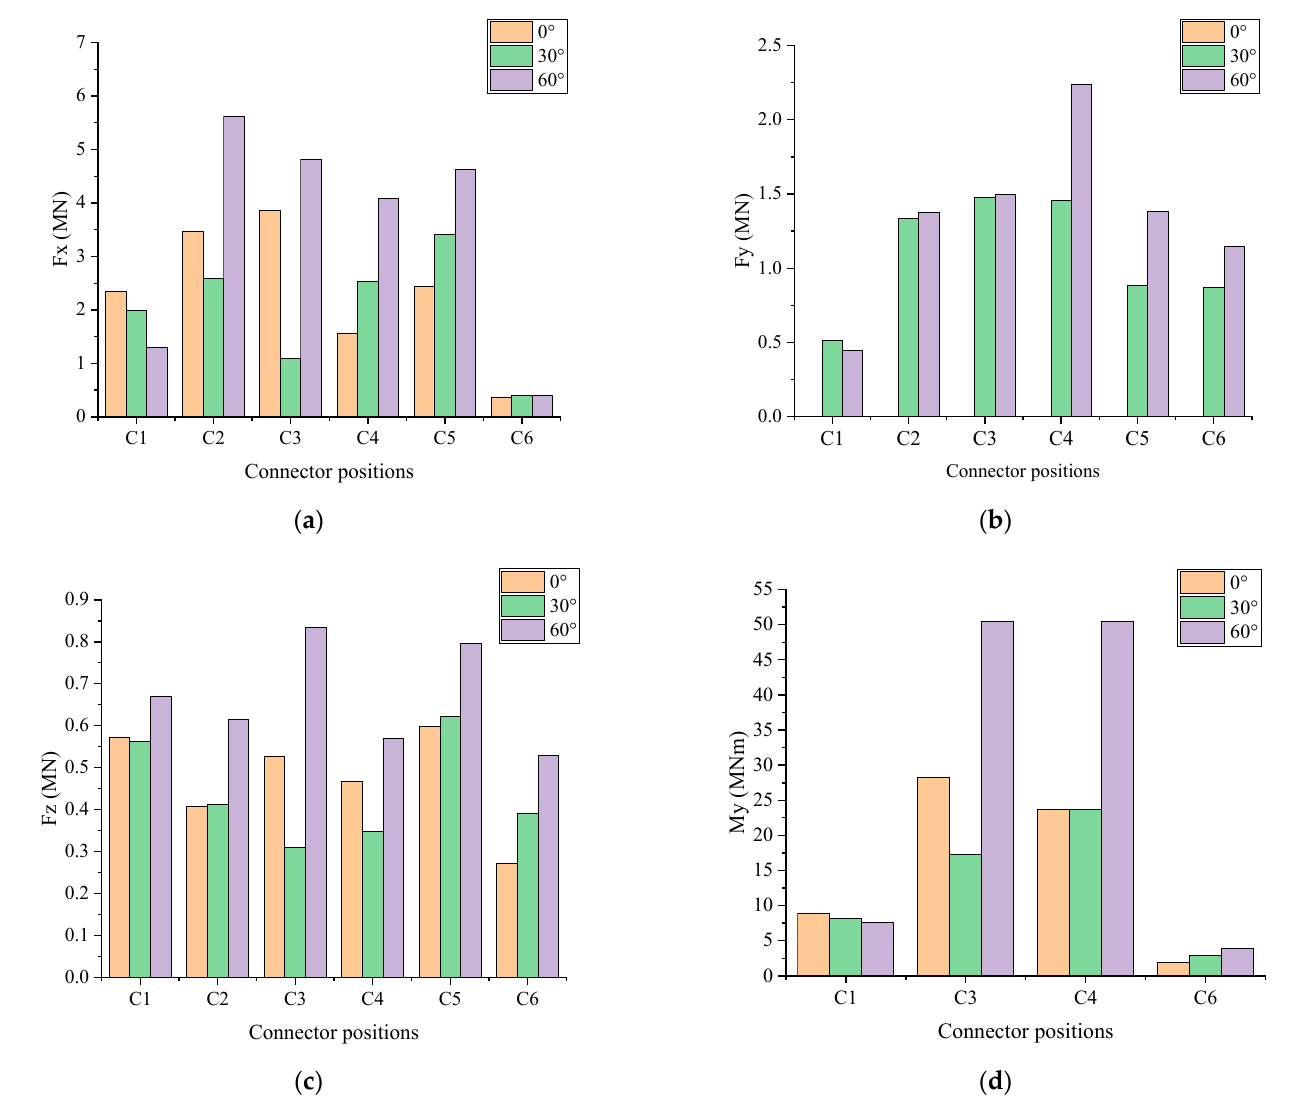
Figure 6. Comparison of main connector forces of each connector under different incident wave angles: ( a ) horizontal force; ( b ) vertical force; ( c ) shear force; ( d ) pitch bending moment.